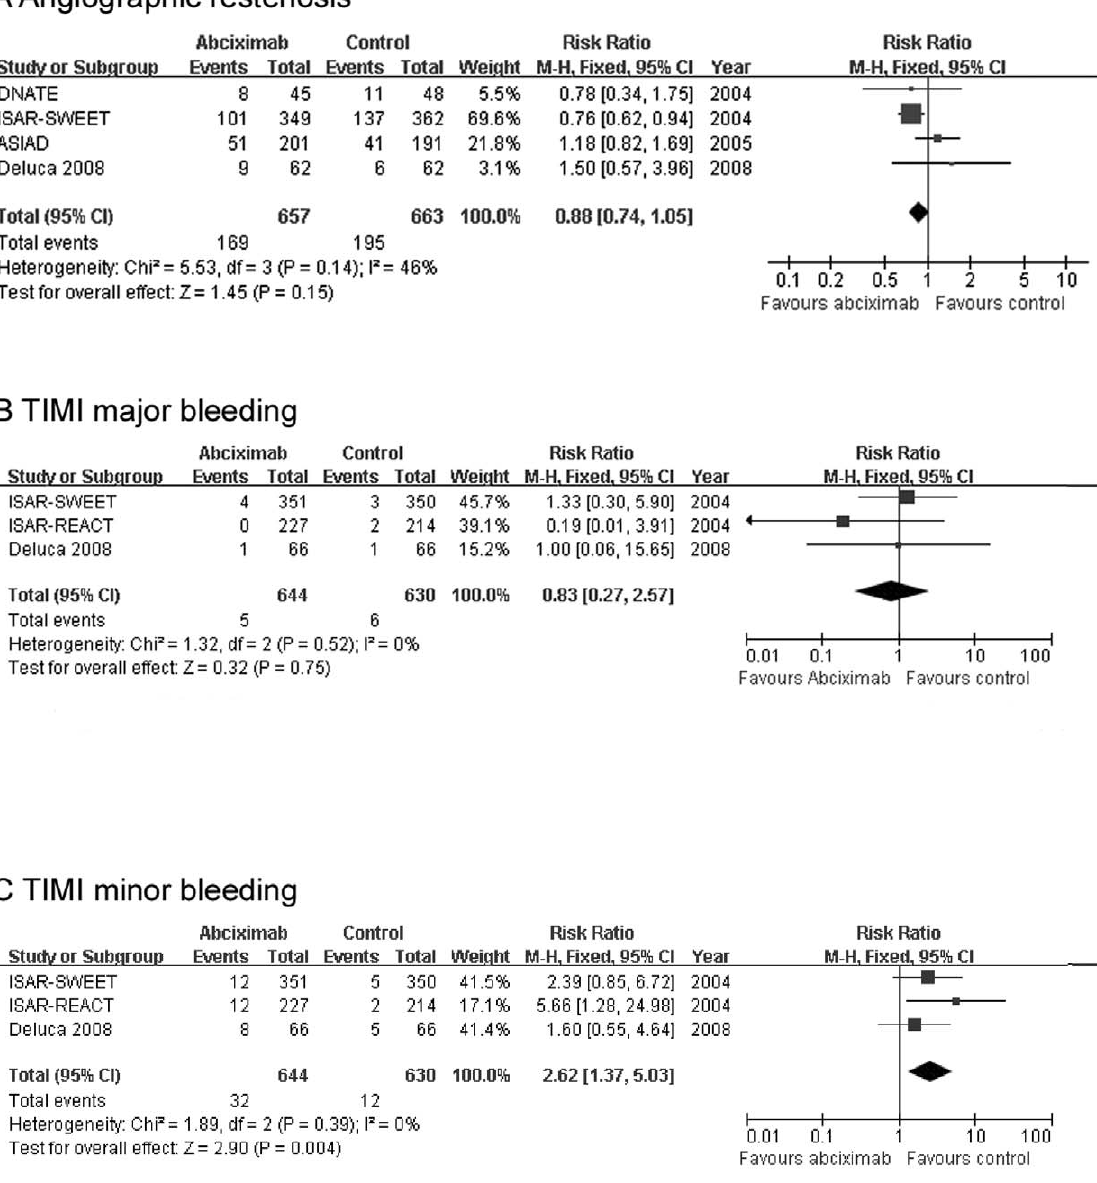
Figure 4. Comparison of secondary endpoints between abciximab and control group in patients with elective PCI. Efficacy of abciximab compared with control for (A) angiographic restenosis (B) TIMI major bleeding in diabetic patients with elective PCI; (C) TIMI minor bleeding in diabetic patients with elective PCI.